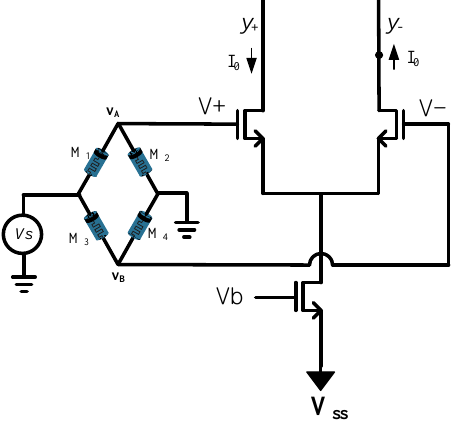
Figure 7. Memristor bridge synaptic circuit. The memristor bridge on the left performs the weighting operation while the differential amplifier on the right performs the voltage to current